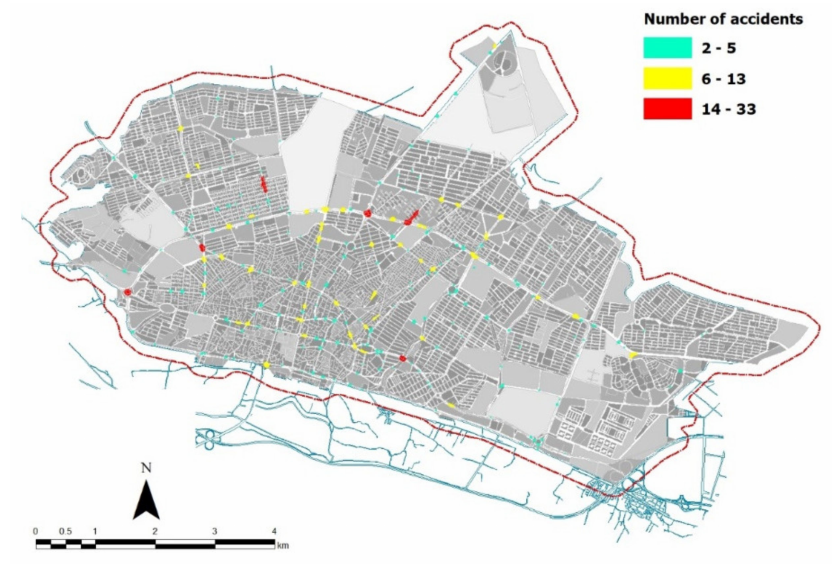
Figure 6. Spatial distribution of high spatiotemporal interactions of car accidents in